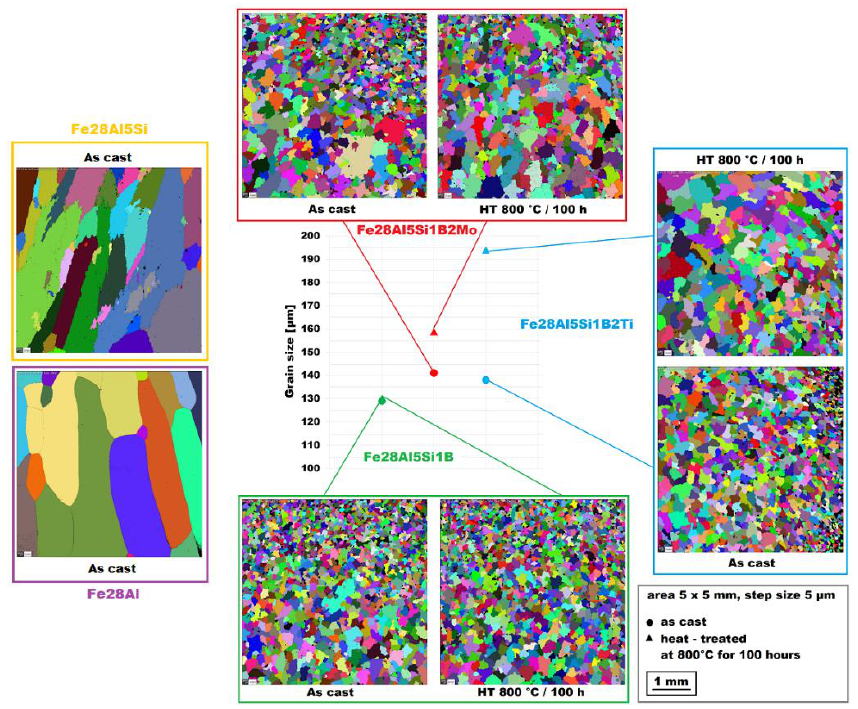
Figure 1. The grain size of investigated alloys in the as-cast state and also after heat treatment at 800 °C for 100 h (the Fe28Al and Fe28Al5Si alloy added for comparison).